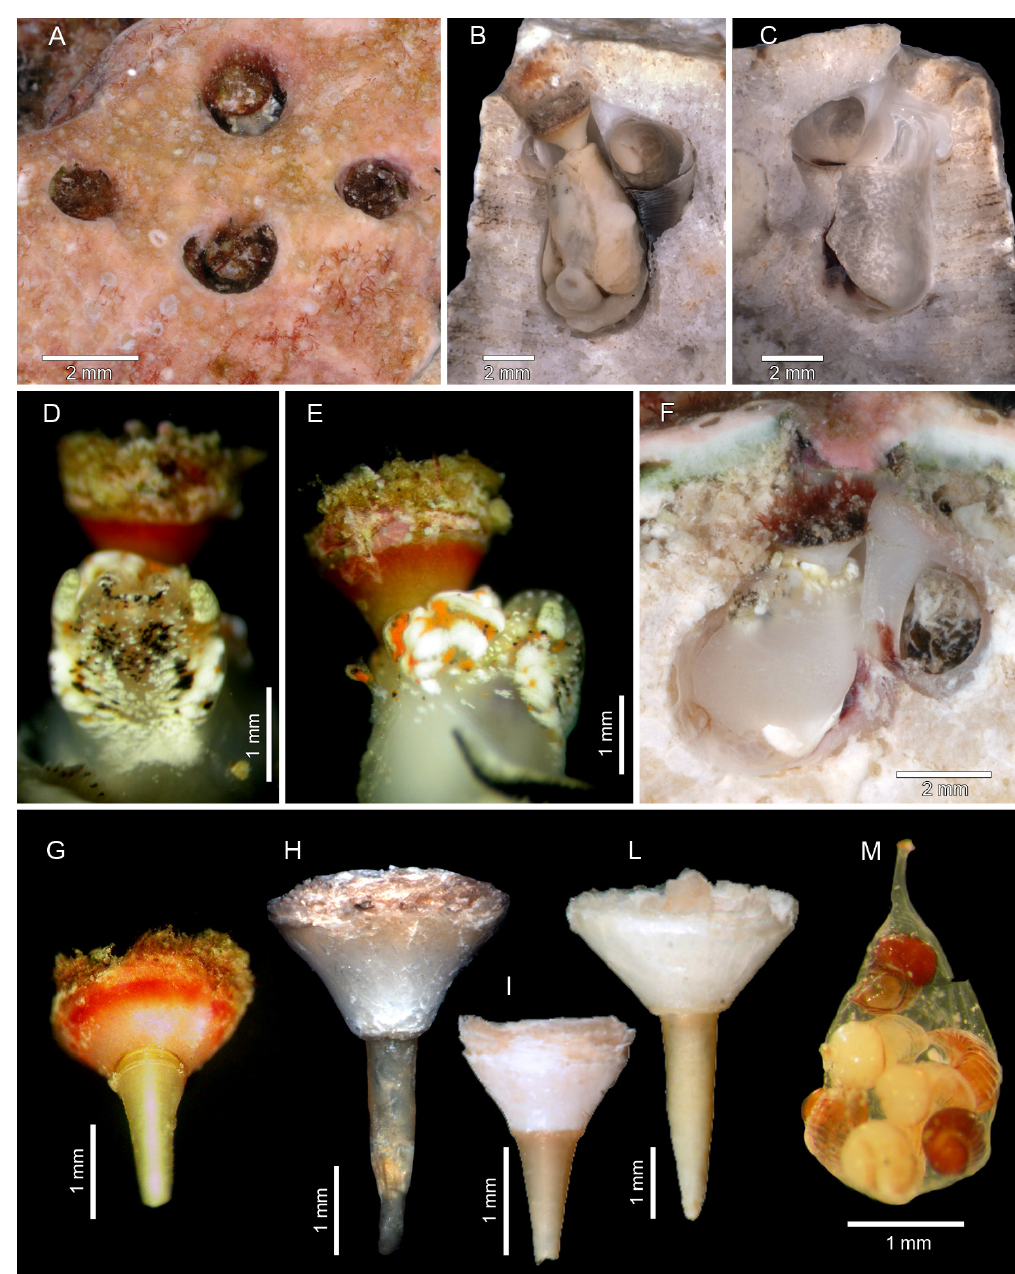
Fig. 1. Novastoa rapaitiensis sp. nov. A . Living specimens embedded in coral substrate with only apertures and heavily encrusted opercula visible (UF 400847 , Moorea Island, French Polynesia, photographs by G. Paulay). B–C . Preserved specimen fractured in plane perpendicular to surface, showing both halves of broken shell and animal embedded in coral (UF 436684, Moorea Island, French Polynesia). D–E . Living specimen from Rapa Iti (MNHN IM-2000-31685) just after extraction from the shell. F . Living specimen embedded in coral that has been fractured in plane perpendicular to surface (UF 400849). – G–L . Lateral views of opercula. G . Operculum from Rapa Iti as photographed in the field just after dissection (not from the type series). H . Operculum from the Moorea Island population, French Polynesia (UF 436684). I . Operculum from the Rapa Iti Island population, French Polynesia (MNHN IM-2000-31684). L . Operculum from the Yonge Reef population, Australia (AM C.464342). – M . Egg capsule after removal from interior shell wall (more developed embryos shown in Fig.